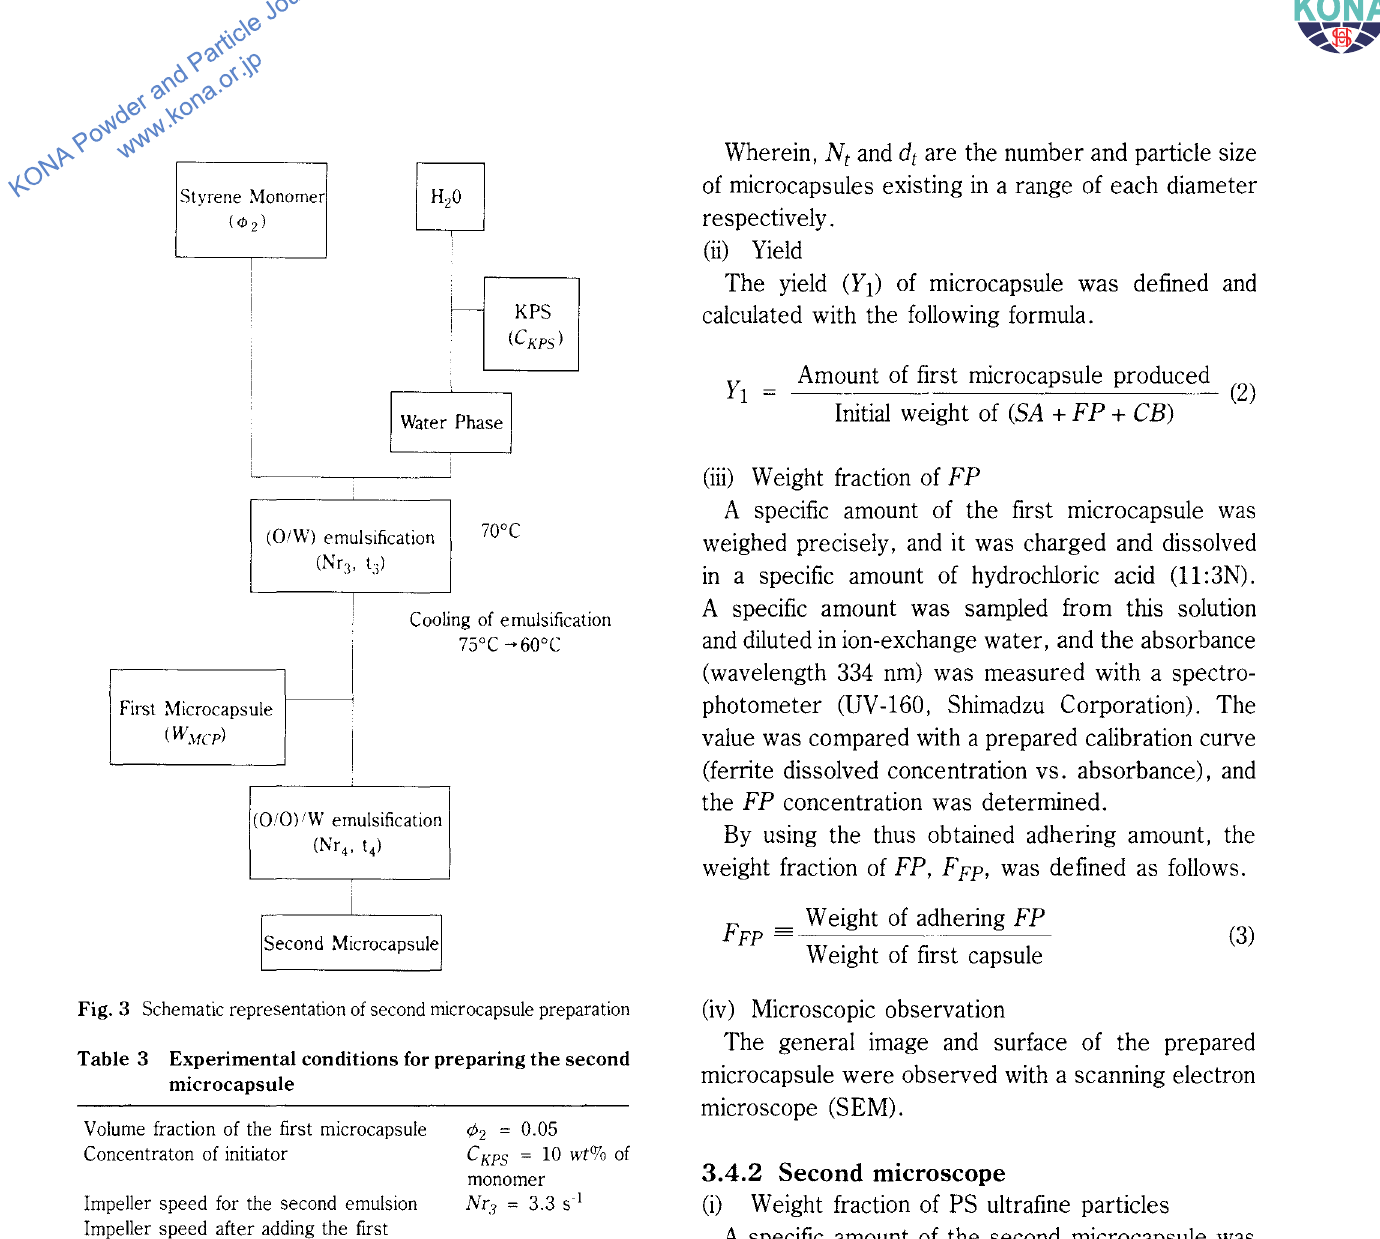
Table 4 Operating conditions for preparing the second